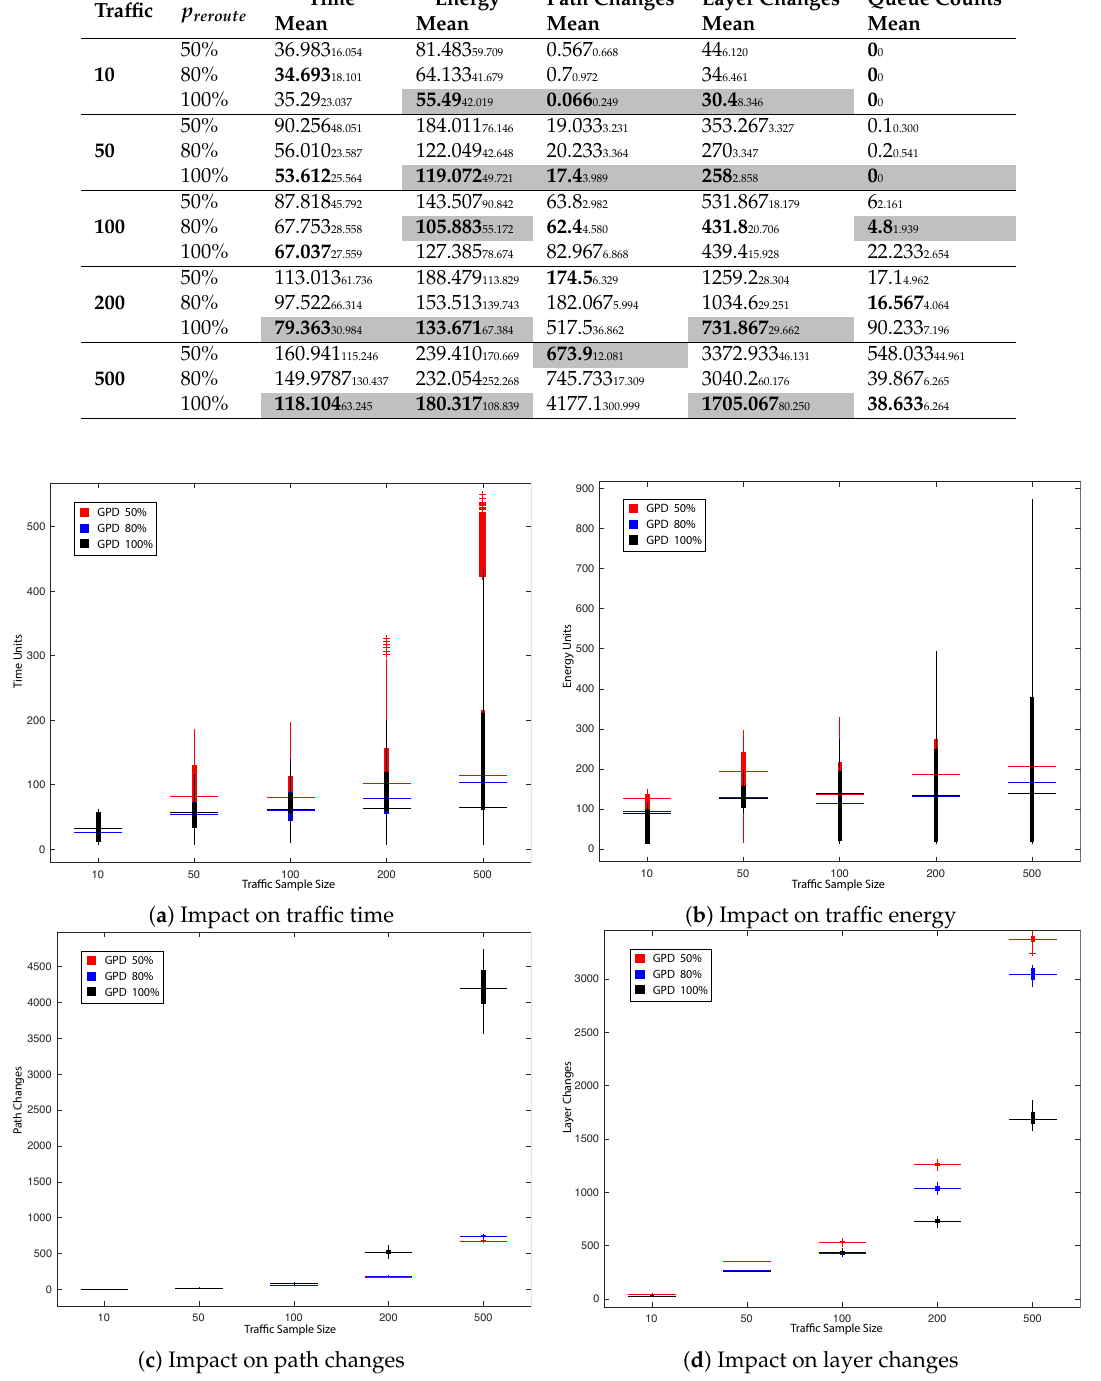
Figure 9. Impact on mixed objective traffic performance by varying p reroute in GPD (50%, 80%,